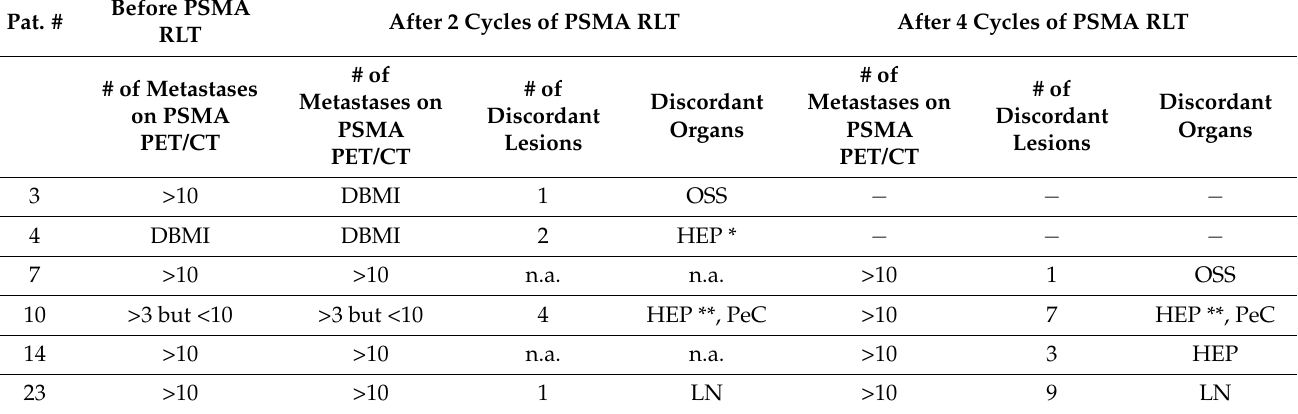
Table 2. Findings of the patients with discordant lesions after two and four cycles of PSMA